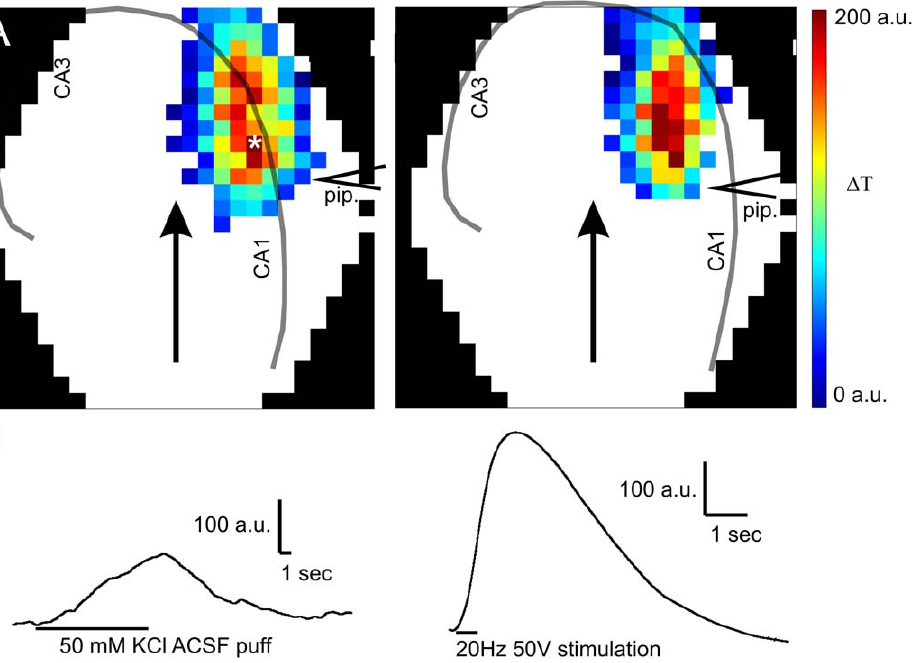
Figure 6. Spatial and temporal patterns of elevated [K + ]-evoked and afferent stimulation evoked IOS are significantly different. A: IOS amplitude maps after application of elevated [K + ] ACSF ([K + ]=50 mM) onto the surface of the slice in the str. oriens ( Left ) or in the str. radiatum ( Right ) from a patch pipette. The position of the patch pipette (pip.) is indicated by the symbol ‘‘ , ’’. Transparent lines indicate the pyramidal layer and the arrow indicates the direction of the buffer flow. The colorbar indicates the maximum change of the transmittance compared to the resting light intensity. B: Comparison of the shape of representative IOS traces evoked by elevated [K + ] ( Left ) and afferent stimulation ( Right ) at the site marked by asterisk in A